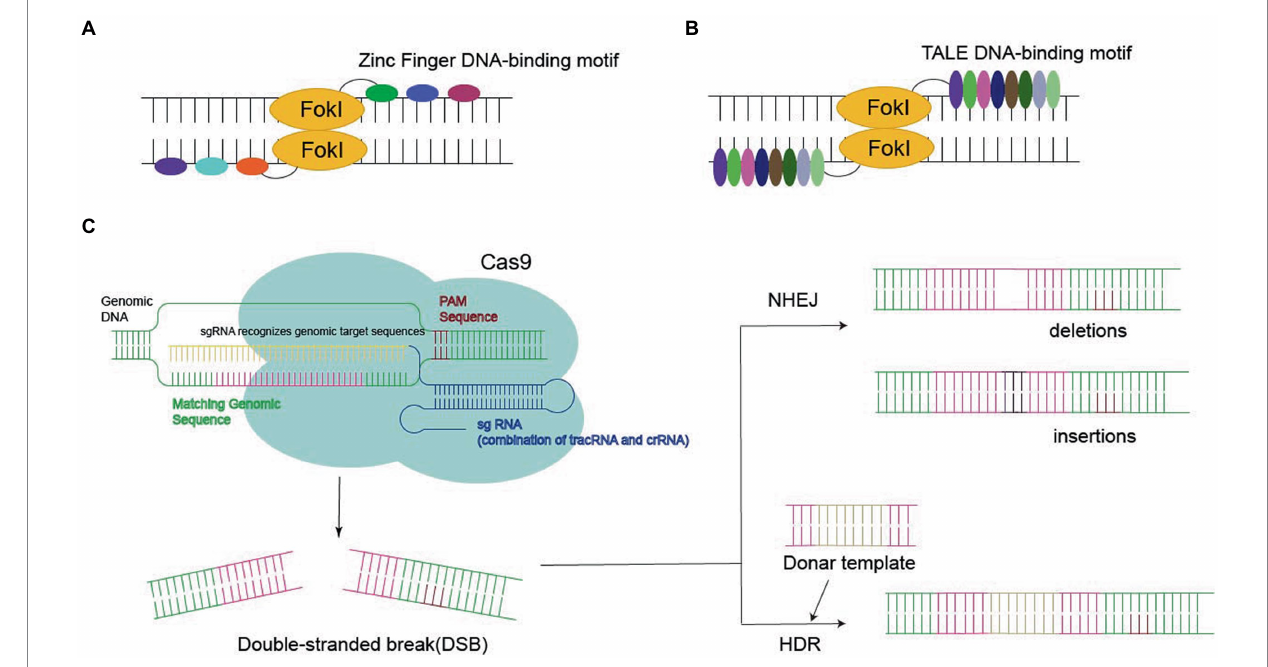
FIGURE 2 Three nucleases required for gene editing: (A,B) Zinc Finger DNA-binding motif or TALE DNA-binding motif bind to FokI in the target sequence, eventually leading to double-stranded break (DSB). (C) CRISPR-Cas9 systems generate the DSB, leading to gene deletion or insertion by homology- directed repair (HDR) or non-homologous end joining